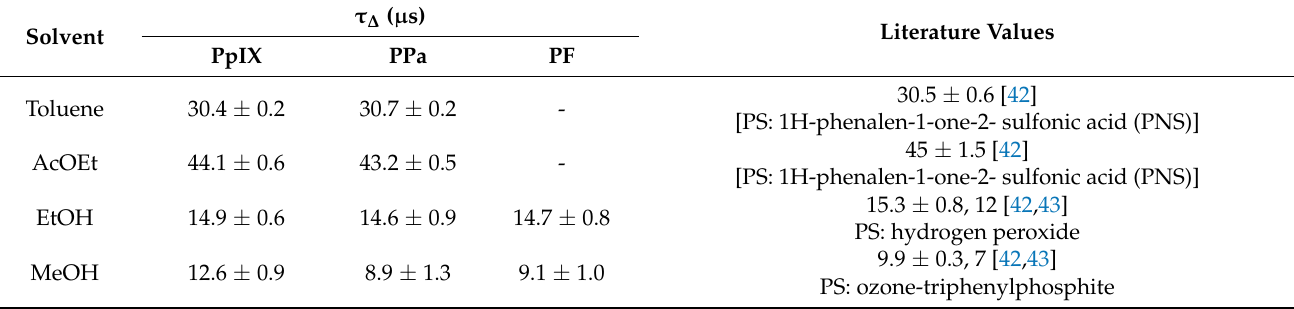
Table 6. 1 O 2 lifetime of PpIX, PPa, and PF in different solvents at room temperature ( c = 1.87 μ M).